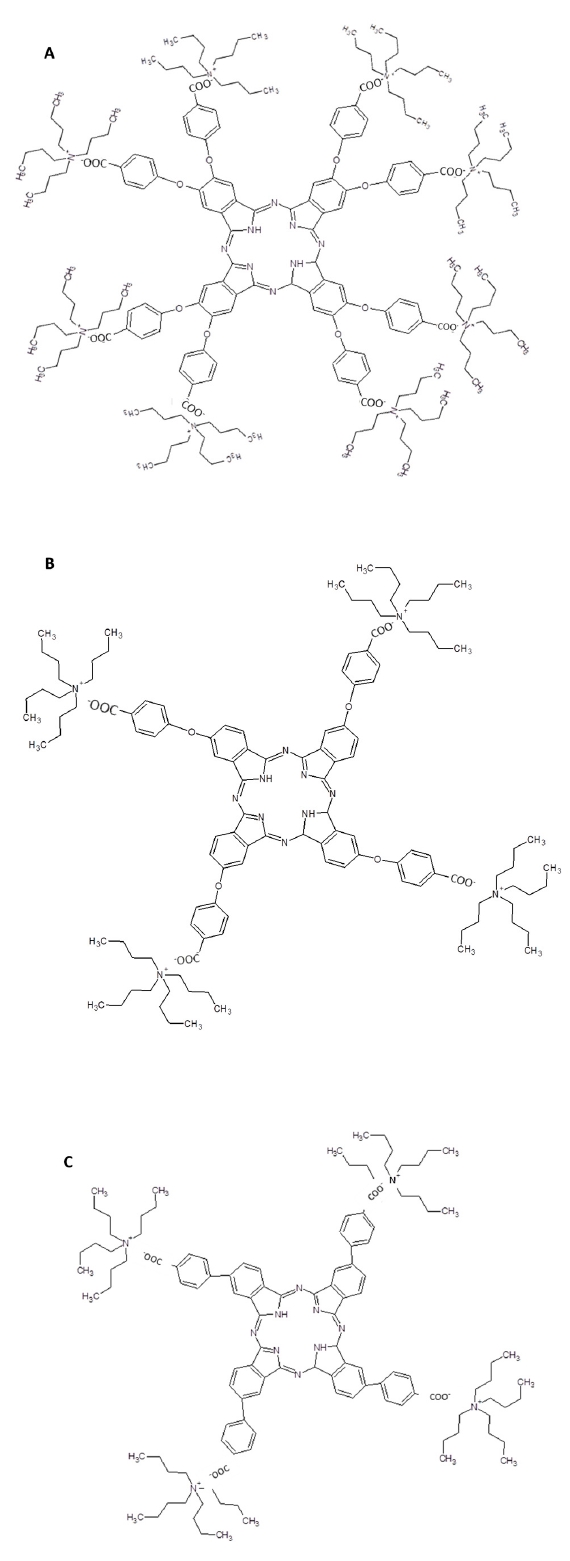
Figure 9. Chemical structures of the three carboxylated phthalocyanines used to form the Figure9. Chemicalstructuresofthethreecarboxylatedphthalocyaninesusedtoformtheelectrostatically electrostatically bounded supramolecular dyads with Li + @C 60 [84]. A , B and C are the three bounded supramolecular dyads with Li + @C 60 [84]. ( A – C ) are the three phthalocyanine derivatives phthalocyanine derivatives used to form complexes with fullerenes. used to form complexes with